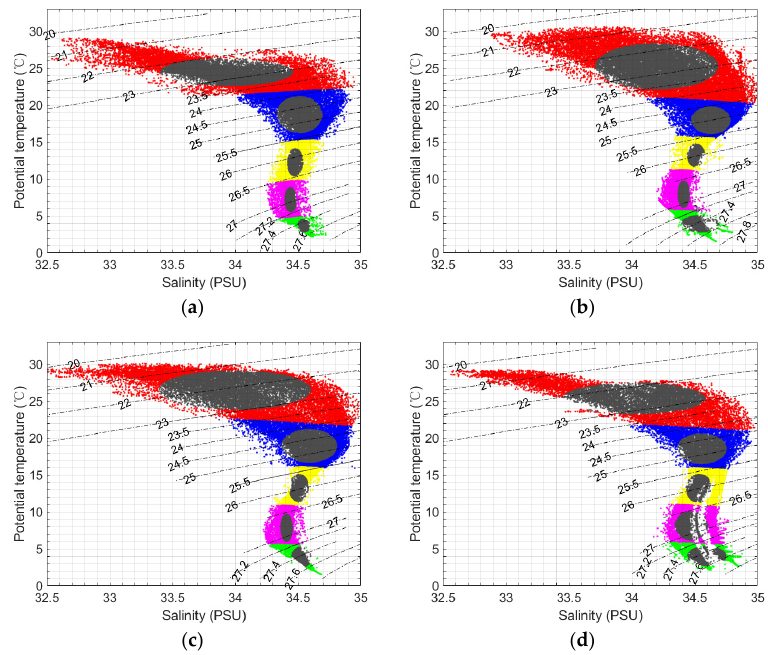
Figure 2. T-S diagram of the water mass in the vertical division. ( a ) Winter, ( b ) spring, ( c ) summer, and ( d ) autumn. Red scatter: the surface water; blue scatter: the subsurface water; yellow scatter: the subsurface–intermediate mixing water; pink scatter: the intermediate water; green scatter: the deep water.